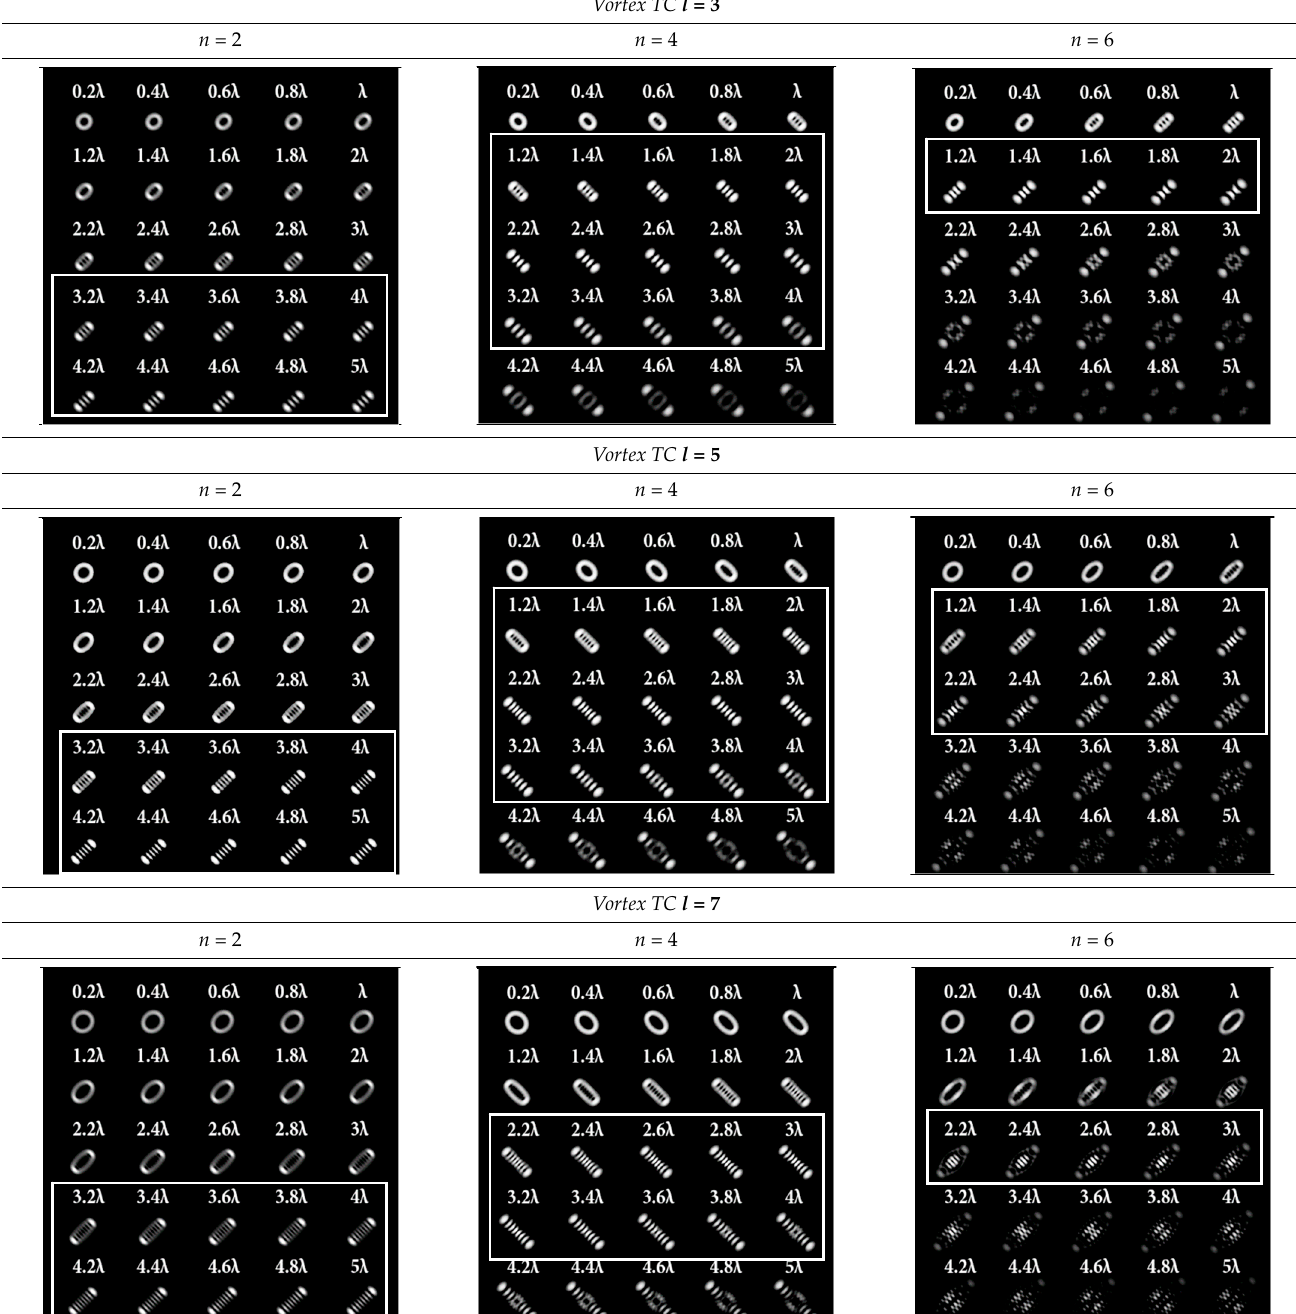
Table 6. Simulation results for multi-channel DOEs matched with one type of aberration Z n ,2 ( r , ϕ ) ( n = 2, 4, 6) with α ranging from 0.2 λ to 5 λ when illuminated with a vortex beam with a TC l = 3, 5, 7.